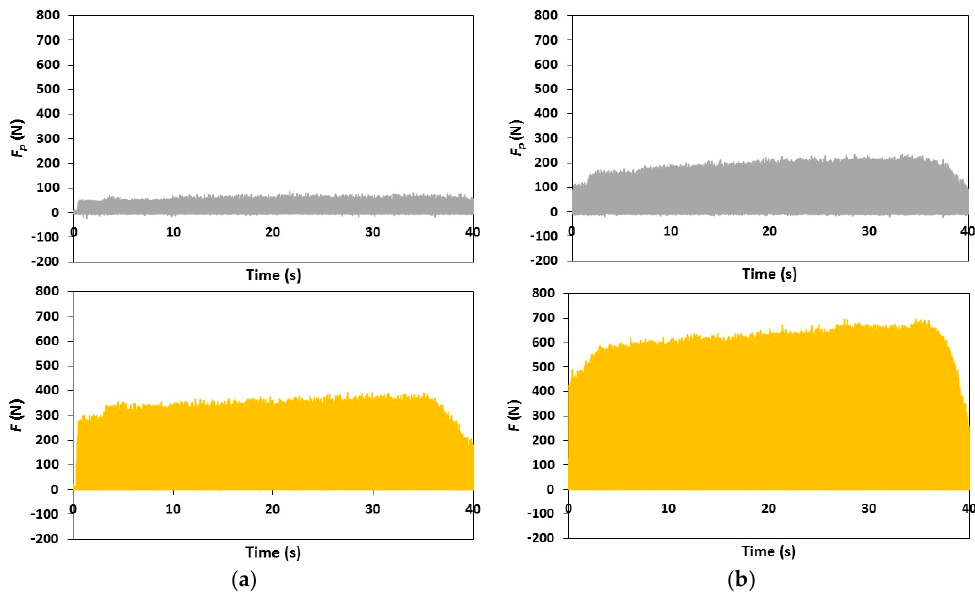
Figure 9. The whole F f , F fN , F p and F curves (recorded data) of Tool dry2 milling experiment: ( a ) during the first pass, and ( b ) during the third pass.